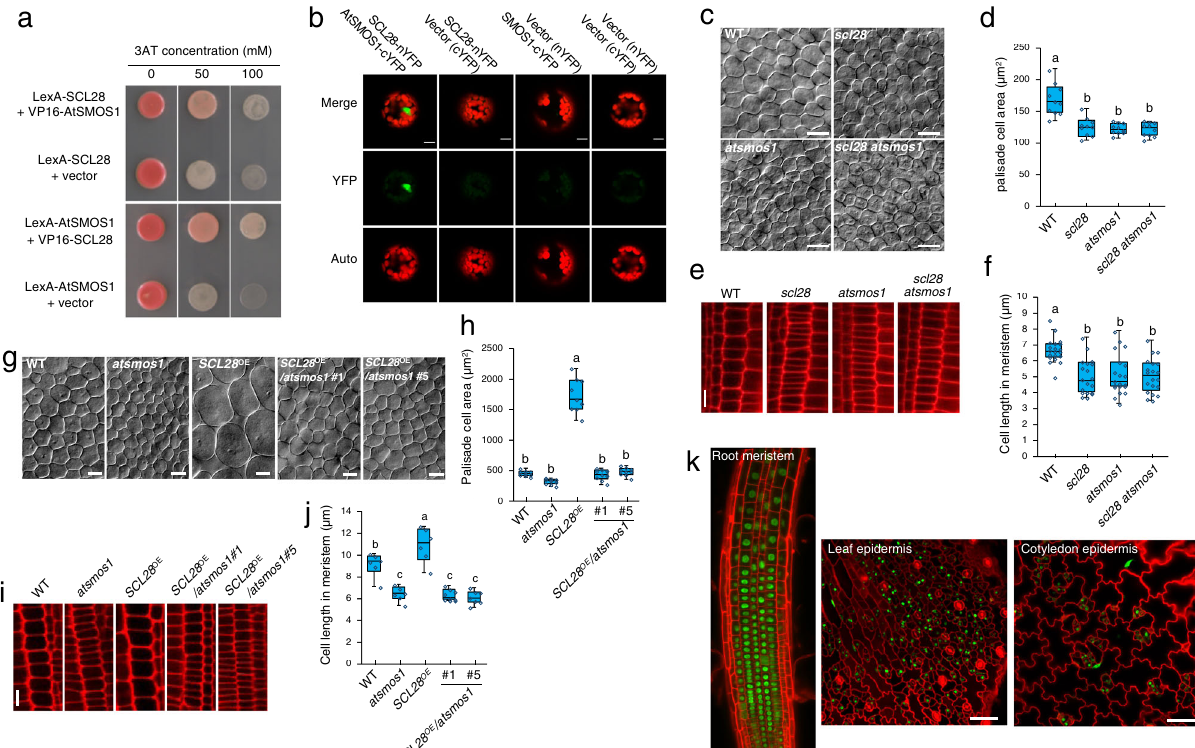
Fig. 4 Formation of active heterodimer between SCL28 and AtSMOS1. a SCL28-AtSMOS1 interaction in yeast two-hybrid assay. Yeast strains carrying two indicated constructs were grown on synthetic medium lacking His and containing indicated concentration of 3-amino-1,2,4-triazole (3-AT). b SCL28- AtSMOS1 interaction in bimolecular fl uorescence complementation (BiFC) analysis. YFP fl uorescence (YFP), auto fl uorescence of chloroplasts (Auto) and their merged image (Merge) were taken from mesophyll protoplasts that were transfected with the indicated plasmid constructs. Scale bars indicate 10 µ m. The BiFC experiment was repeated twice with similar results. c Leaf palisade cells were observed by DIC microscopy using fi rst leaf pairs from WT plants, and scl28 , atsmos1 , and double scl28 atsmos1 mutants at 10 DAS. Scale bar indicates 20 µ m. d Quanti fi cation of palisade cell area in fi rst leaf pairs from plants with indicated genotypes. Boxplot was generated using data collected from leaves of ten different plants, in each of which more than 50 cells were analyzed (midline = median, box = IQR, whiskers = 1.5 × IQR). Different letters above boxplots indicate signi fi cant differences ( P < 0.05) based on one- way ANOVA and Tukey ’ s test. e Cortical cell fi les were observed by CLSM using PI-stained meristems of primary roots from WT plants, and scl28 , atsmos1 , and double scl28 atsmos1 mutants at 5 DAS. Scale bars indicate 10 µ m. f Quanti fi cation of cortical cell length in root meristems from plants with indicated genotypes. Boxplot was generated using data collected from roots of 20 different plants, in each of which more than 20 cells were analyzed (midline = median, box = IQR, whiskers = 1.5 × IQR). Different letters above boxplots indicate signi fi cant differences as in ( d ). g DIC observation of palisade cells from fi rst leaf pairs of WT, atsmos1 , SCL28 OE plants, and those possessing atsmos1 and SCL28 OE in combination. Plants at 15 DAS were used. Scale bar indicates 20 µ m. h Quanti fi cation of palisade cell area in fi rst leaf pairs from the plants with indicated genotypes. Boxplot was generated using data collected from leaves of nine different plants, in each of which more than 30 cells were analyzed (midline = median, box = IQR, whiskers = 1.5 × IQR). Different letters above the boxplots indicate signi fi cant differences as in ( d ). i CLSM observation of PI-stained root meristems from WT, atsmos1 , SCL28 OE plants, and those possessing atsmos1 and SCL28 OE in combination. Plants at eight DAS were used for observation of cortical cell fi les. Scale bar indicates 10 µ m. j Quanti fi cation of cortical cell length in root meristems of plants with indicated genotypes. Boxplot was generated using data collected from roots of multiple individual plants (midline = median, box = IQR, whiskers = 1.5 × IQR). Number of biological replicates for each line was 6, except for SCL28 OE / atsmos1 #1 for which 9 biological replicates were analyzed. In each plant, more than 20 cells were measured. Different letters above boxplots indicate signi fi cant differences as in ( d ). k Accumulation patterns of AtSMOS1-GFP protein. Root meristem, and epidermis of leaf and cotyledon from plants at six DAS carrying proAtSMOS1::AtSMOS1-GFP were analyzed by CLSM after counterstaining of the cell wall with PI. Similar expression patterns of AtSMOS1- GFP were con fi rmed in multiple independent lines. Scale bars indicate 50 µ insigni fi cant change of AtSMOS1 mRNA in rbr and tcx5 tcx6 might be that RBR- and DREAM-dependent regulation on E2Fs is developmental speci fi c, and was not apparent at the seedling stage.